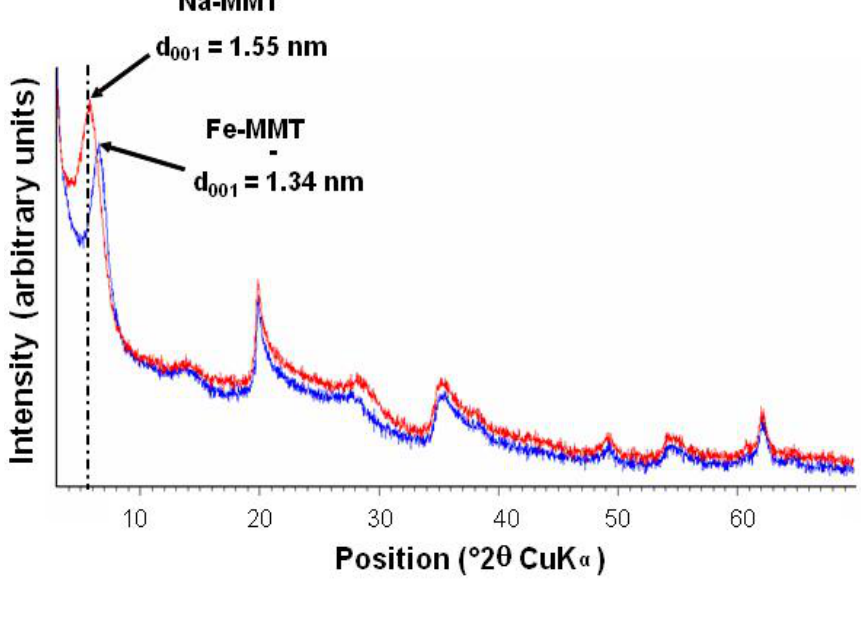
Figure 1. Comparison of the X-ray diffraction (XRD) patterns of Na-montmorillonite (Na-MMT) (red) and maghemite-intercalated montmorillonite ( γ Fe aqueous exchange with Fe 3+